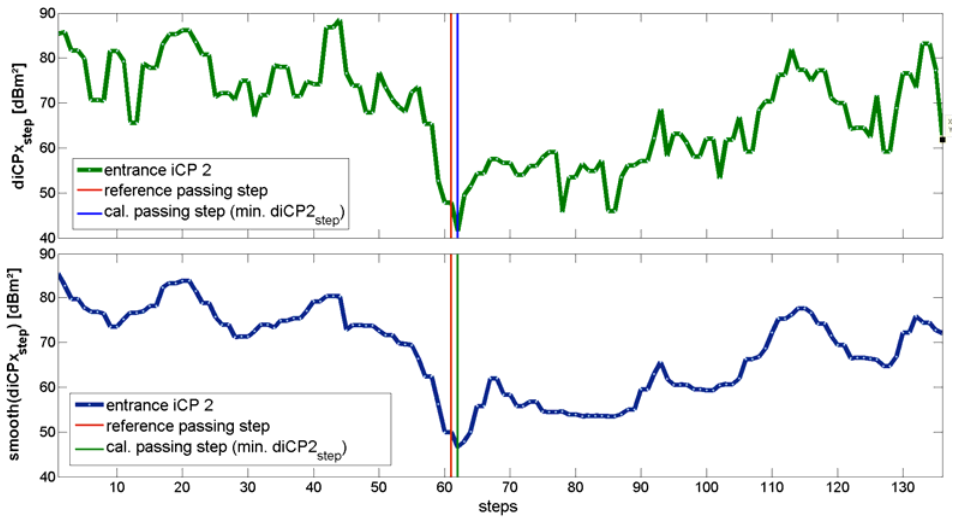
Figure 6. RSS distance values to iCP2 in trajectory TL-EI5